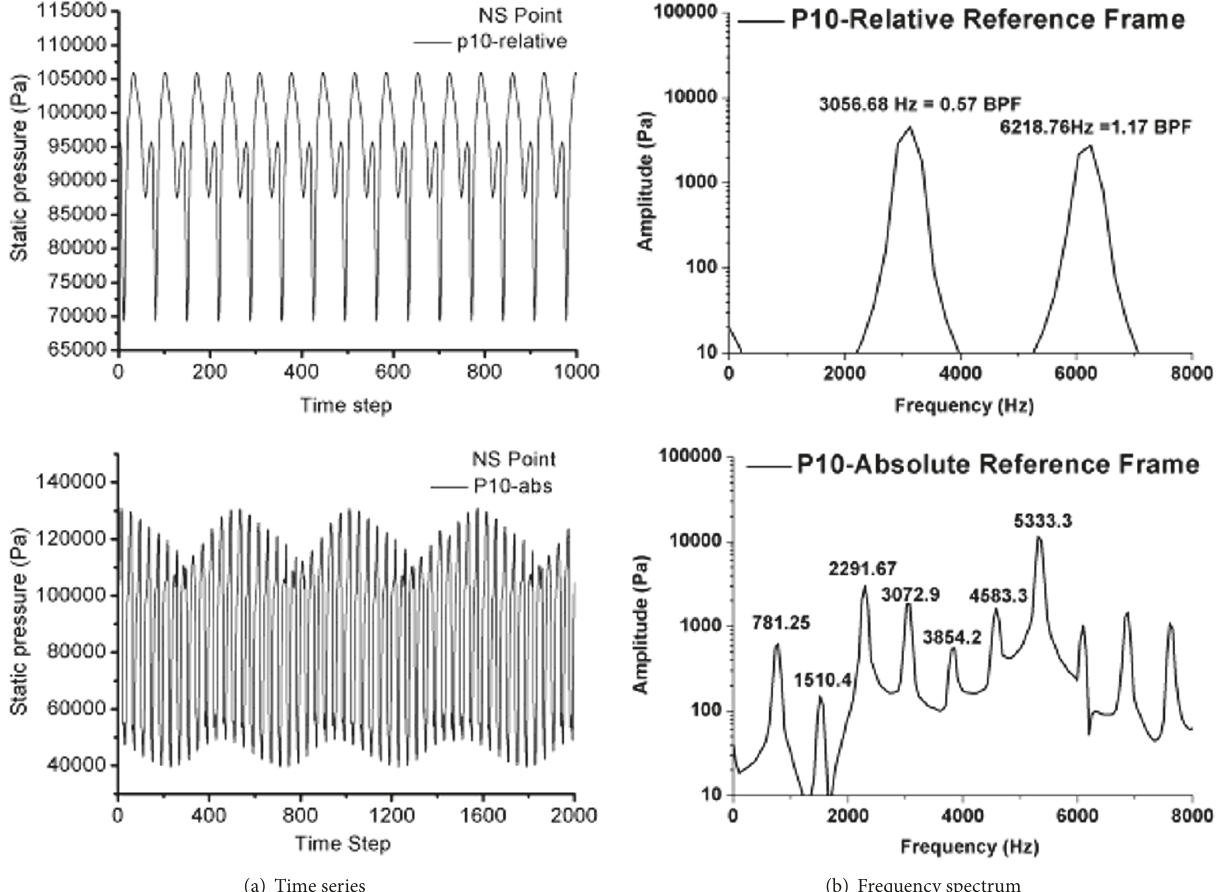
Figure 7: The relation between relative and absolute frames at NS ([12]). Figure reproduced from LIN et al. (2010).